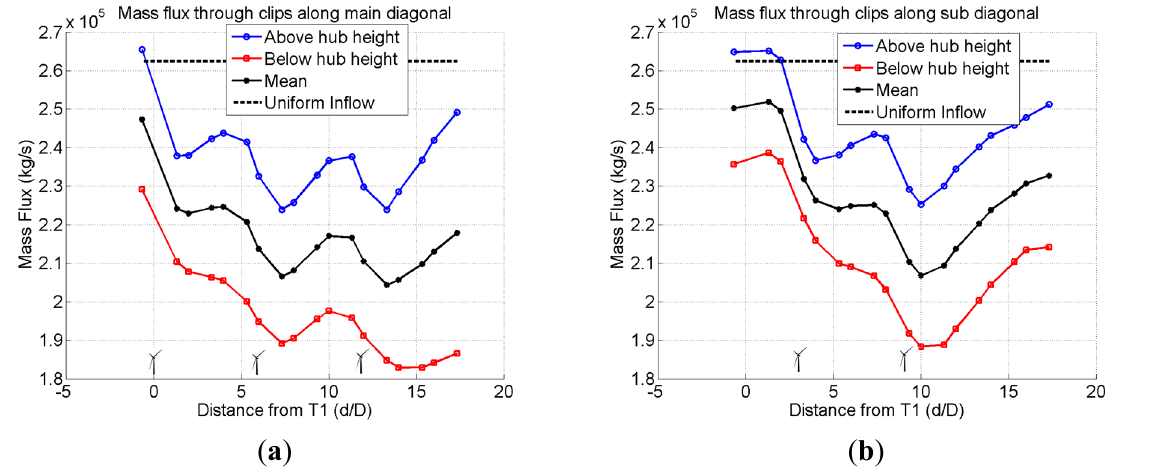
Figure 21. Mass flux across clipped wake surface cutting planes above/below hub height. (5-Turbine Wind Farm, V Wind = 8 m/s). ( a ) Main diagonal (T1–T3); ( b ) Sub-diagonal (T4–T5).